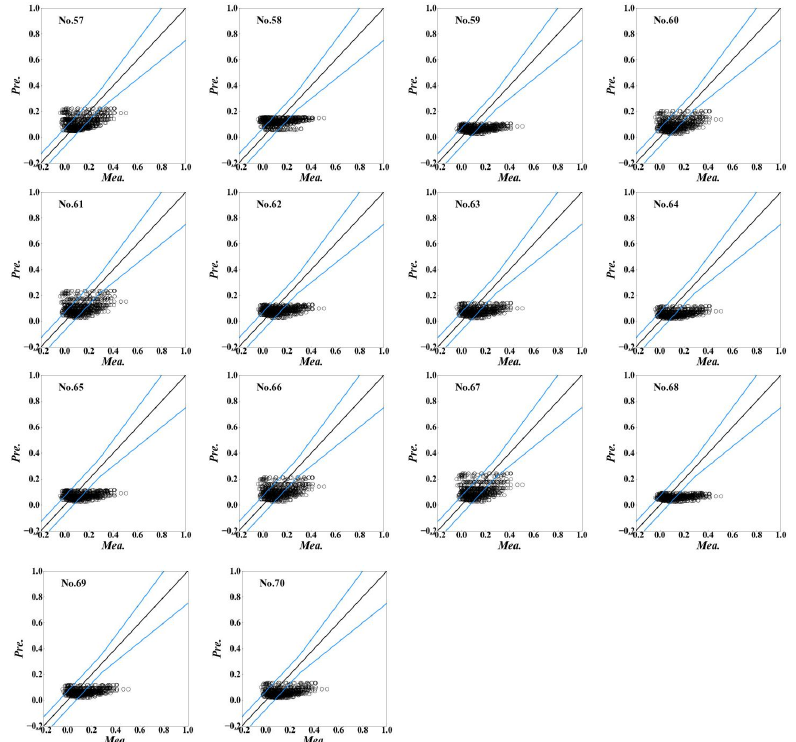
wise distribution of Jensen model.